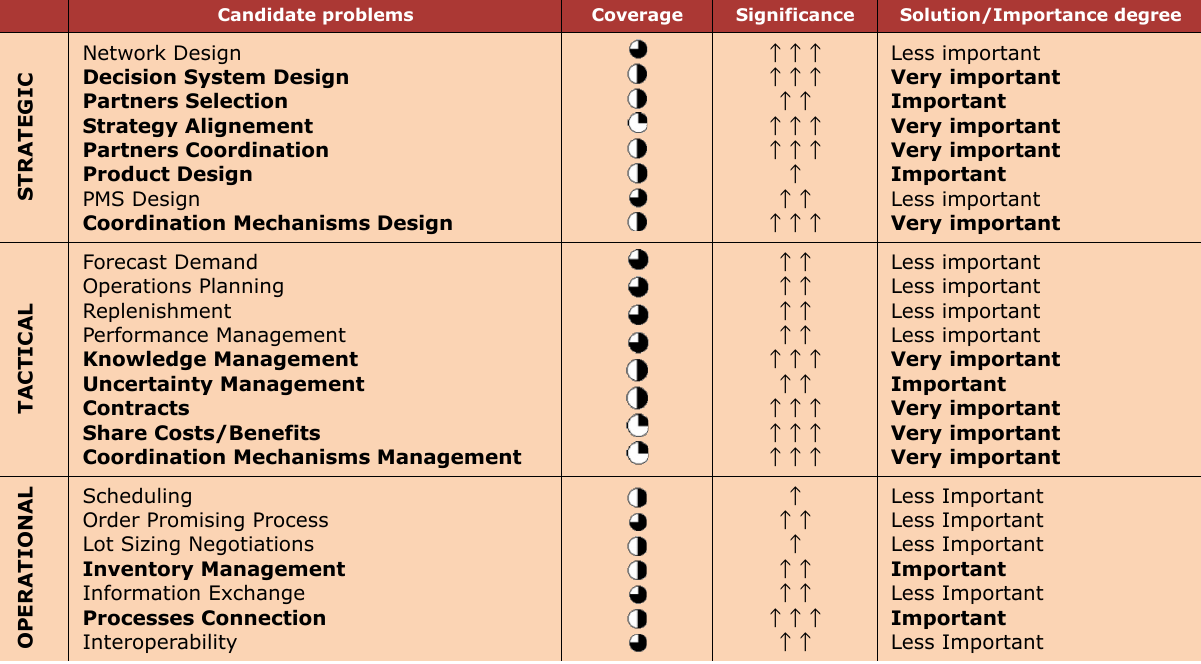
Table 5. Problems classification according the degree of